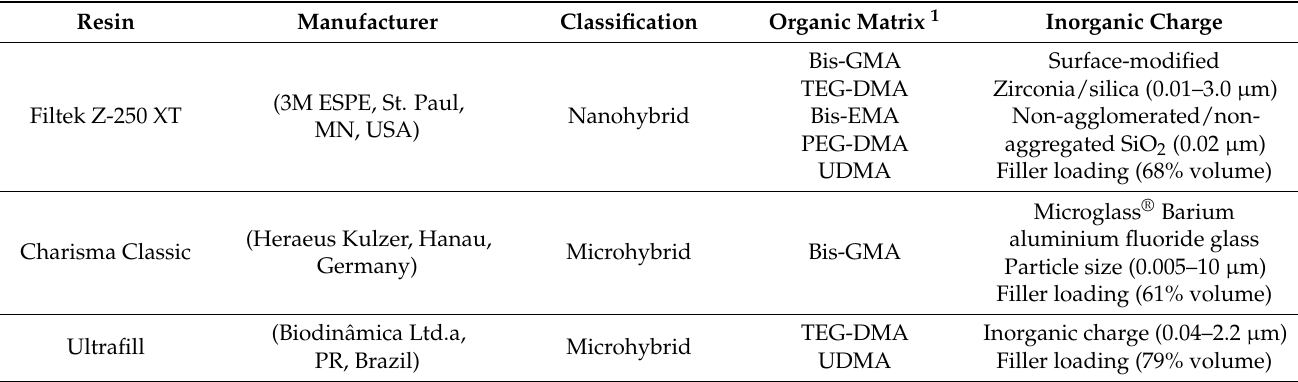
Table 1. Characteristics of each resin composite used in this